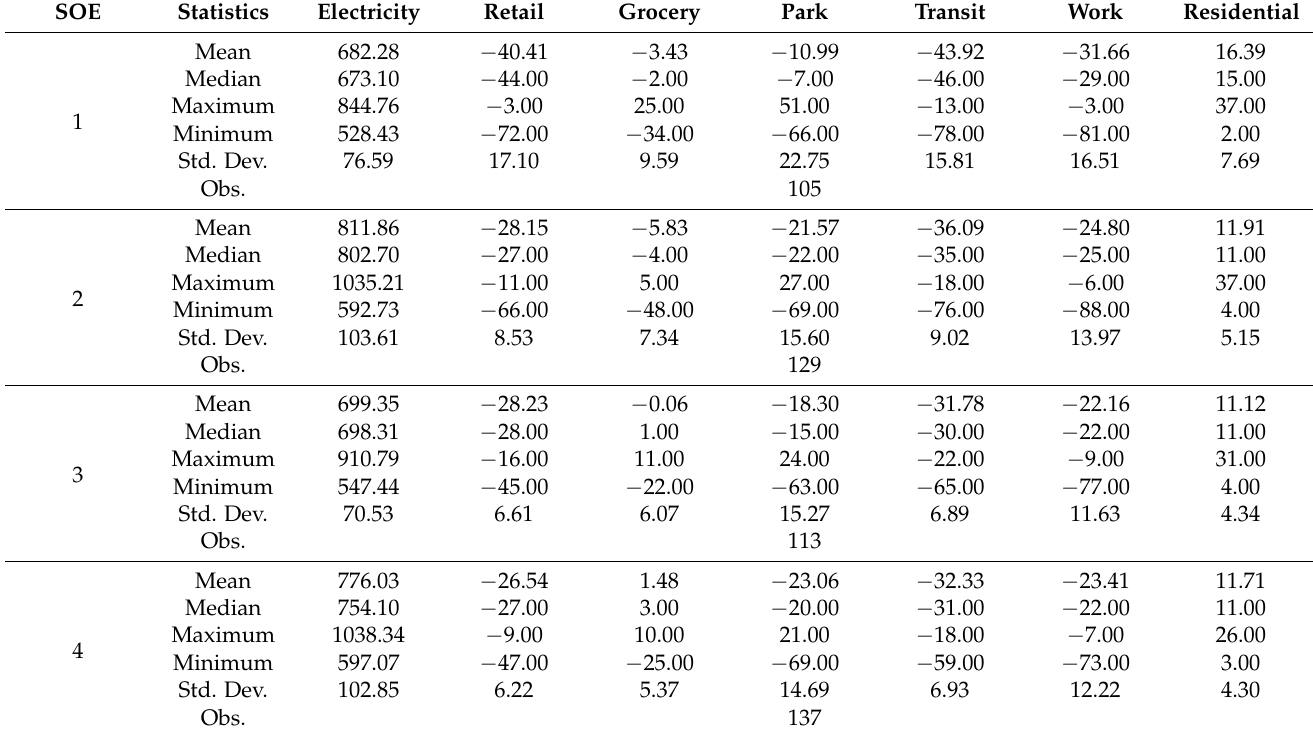
Table 3. Summary